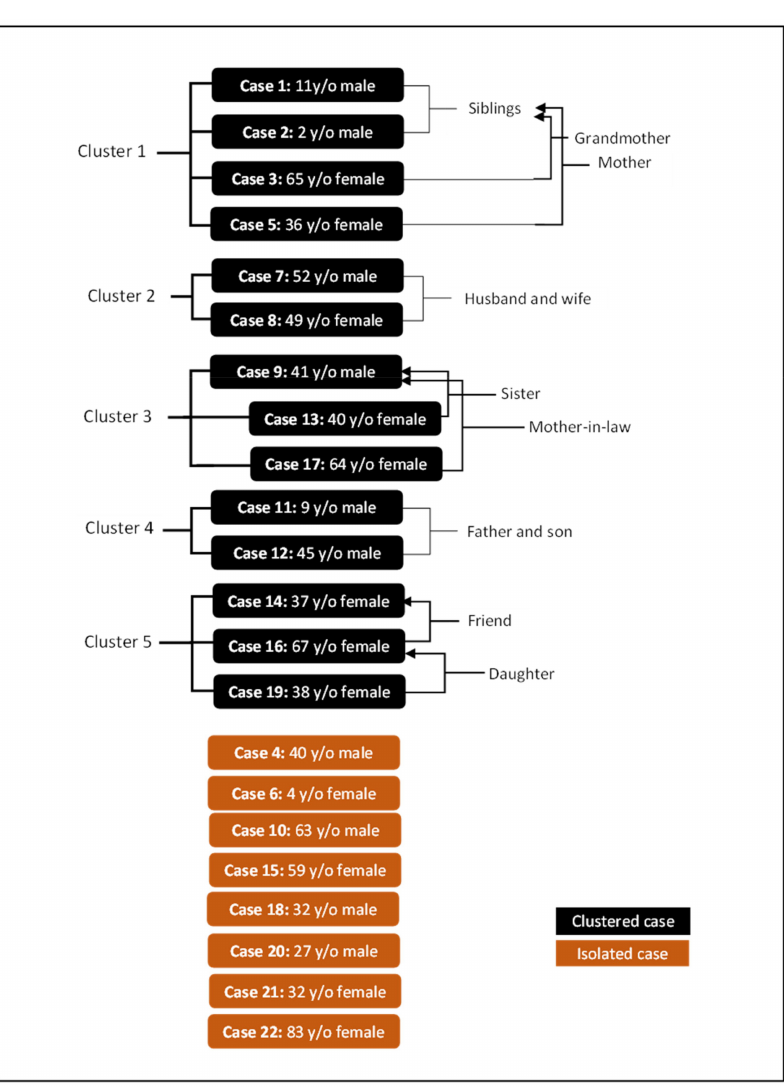
Figure 5. Epidemiological linkages among the first 22 COVID-19 cases in Malaysia.